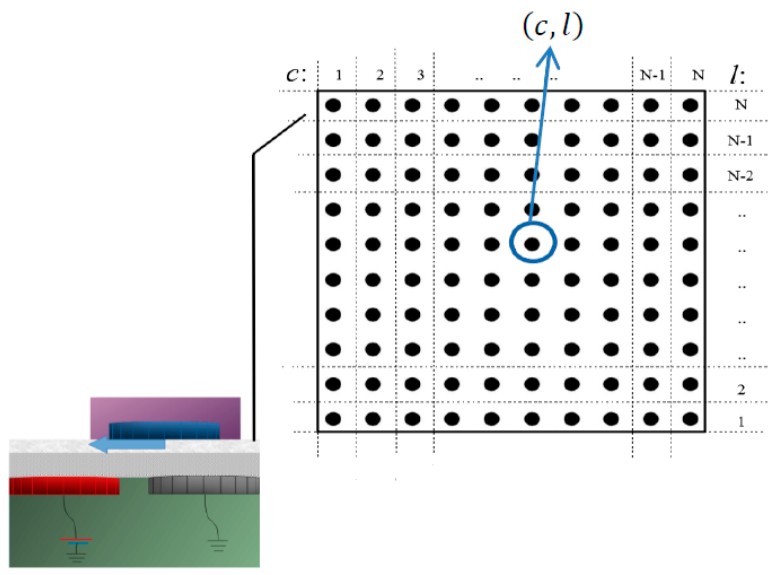
Figure 10. Representation of the electrodes array of the “Smart Platform”.